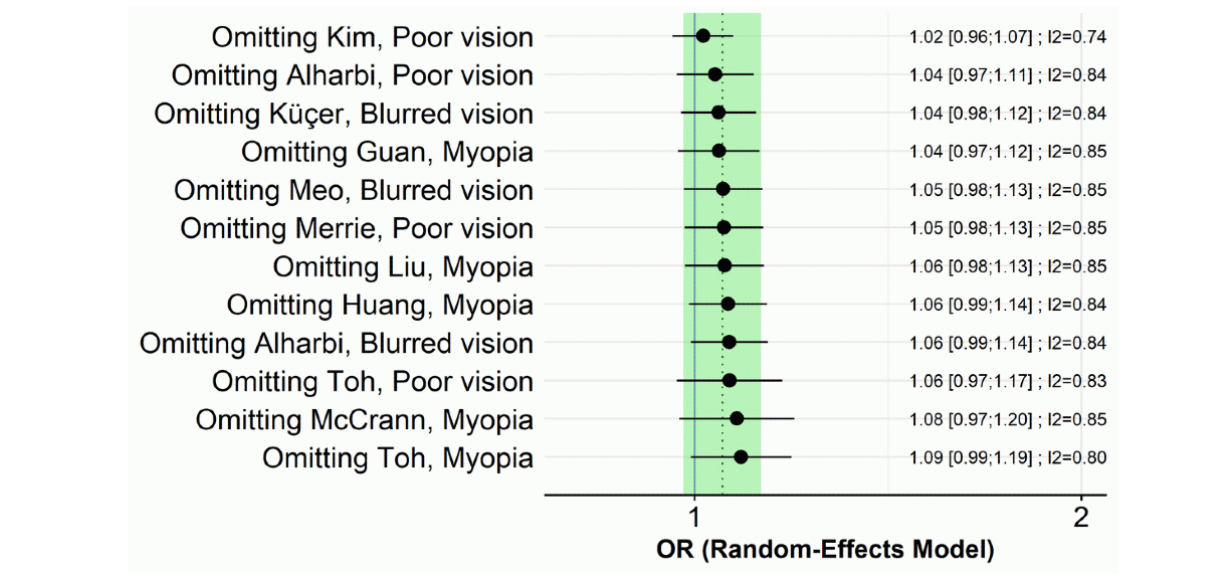
Figure 5. Pooled odds ratios (ORs) of visual impairment in the smartphone overuse group compared to the reduced-use group from leave-one-out